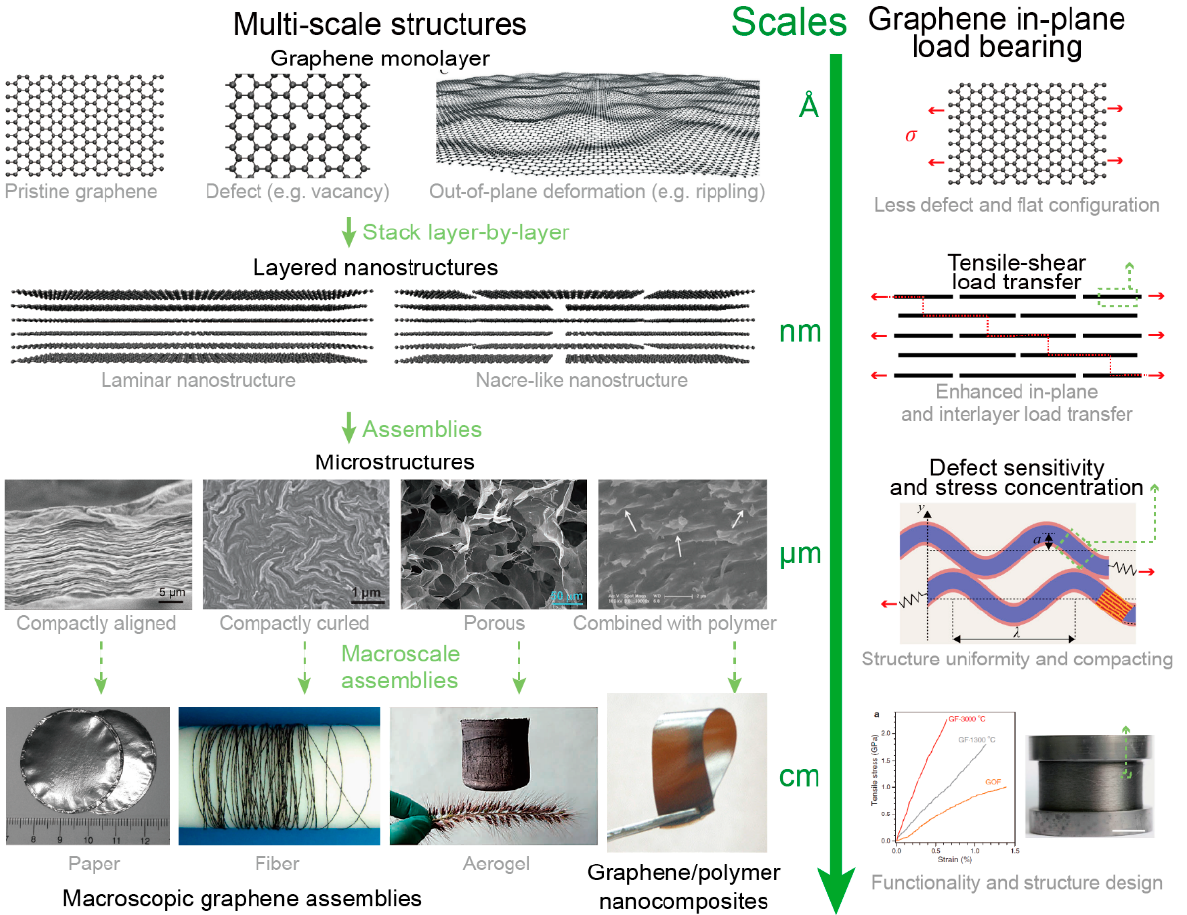
Figure 1. Multi ‐ scale structures of graphene ‐ based materials and the key loading bearing structures Figure 1. Multi-scale structures of graphene-based materials and the key loading bearing structures in each scale. Reprinted in each scale. Reprinted with permission from [8–14]. with permission from